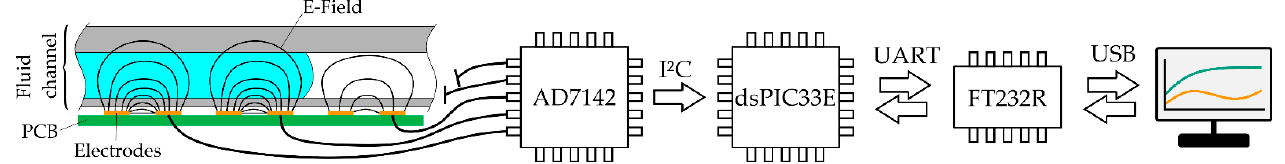
Figure 3. Main hardware components and communication protocols. The capacitance change induced by liquid filling the channel is detected by an AD7142 CDC. The data are continuously polled using a dsPIC33E microcontroller and sent to a control computer whenever requested by the control program at a rate of ~15 Hz.